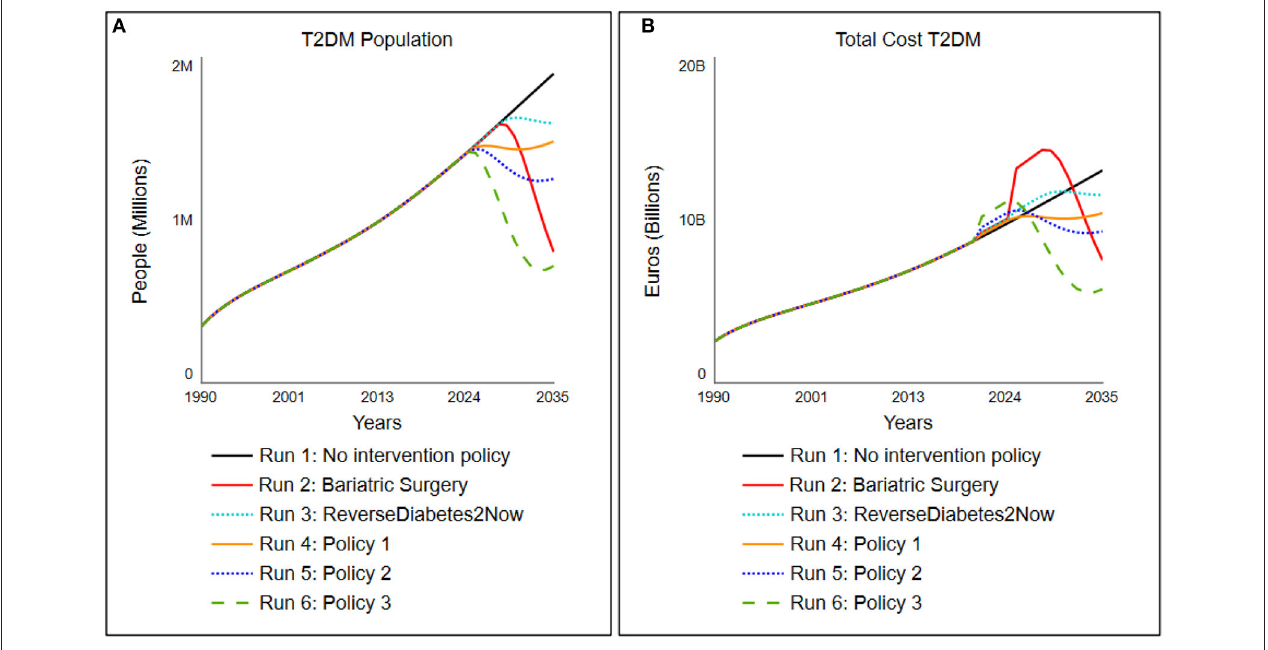
FIGURE 6 | Simulated change in (A) the total cost for society associated with T2DM population and (B) the total T2DM under five different scenarios tested, which are activated in 2020 (details of scenarios indicated in Table 2